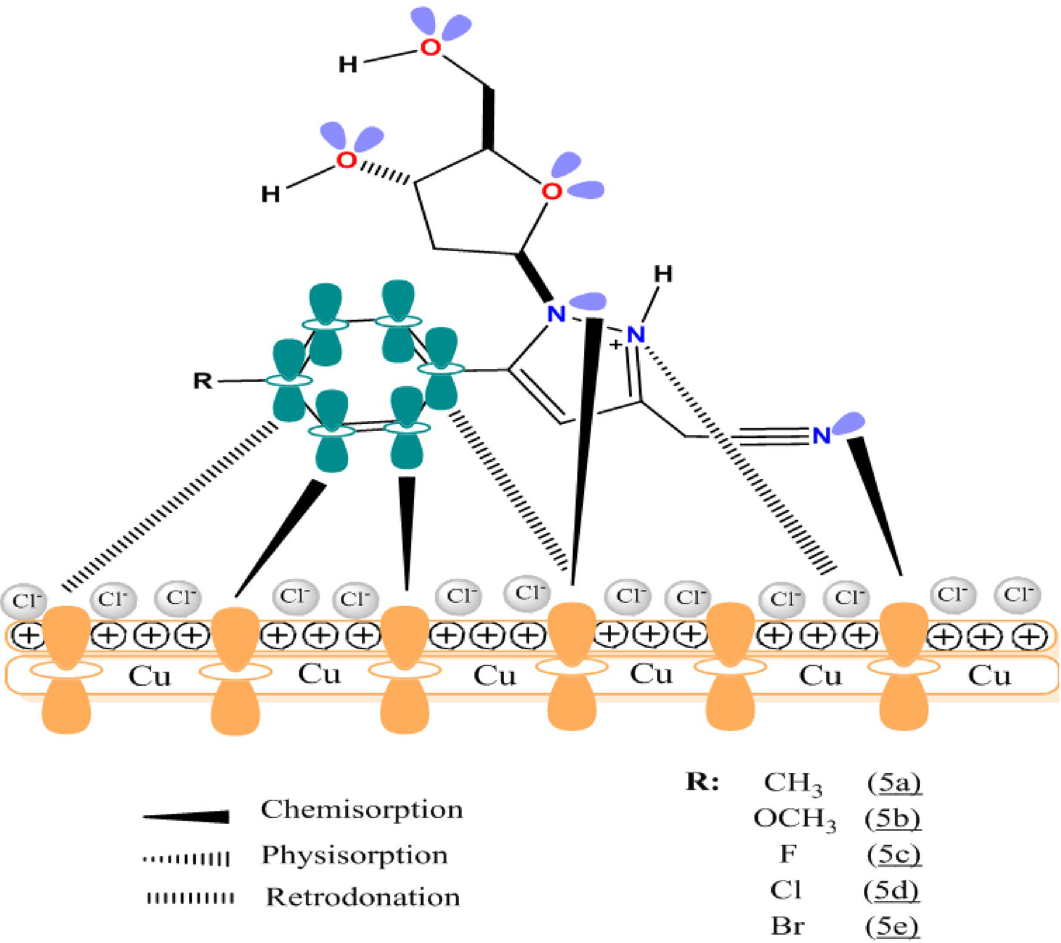
Figure 14. Schematic illustration of the adsorption mechanism of organic corrosion inhibitors 5a – e on the surface of copper in a 1 M HCl